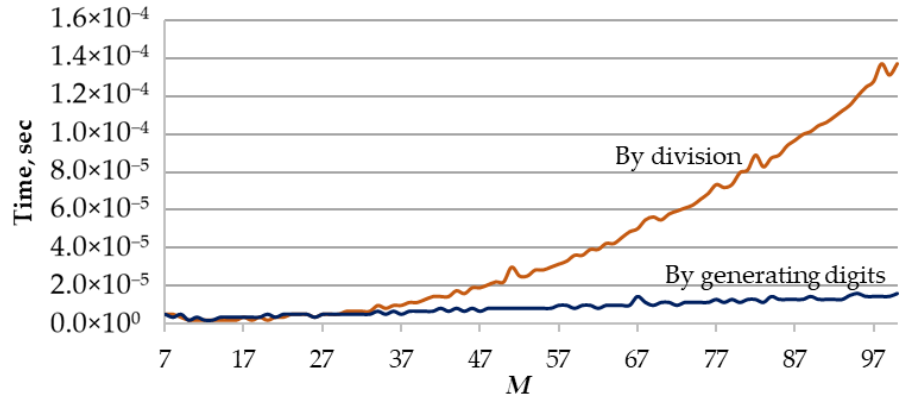
Figure 6. The average time to generate one factorial number using two different algorithms. The achieved graphs indicate that the time to generate a factorial number with the first algorithm (Figure 5) increases with an increase of the M value much faster than the second method. In addition, unlike the first algorithm, the processes for the second algorithm in Figure 5 are convenient for parallelization. This circumstance makes it possible to further increase the performance of the algorithm.